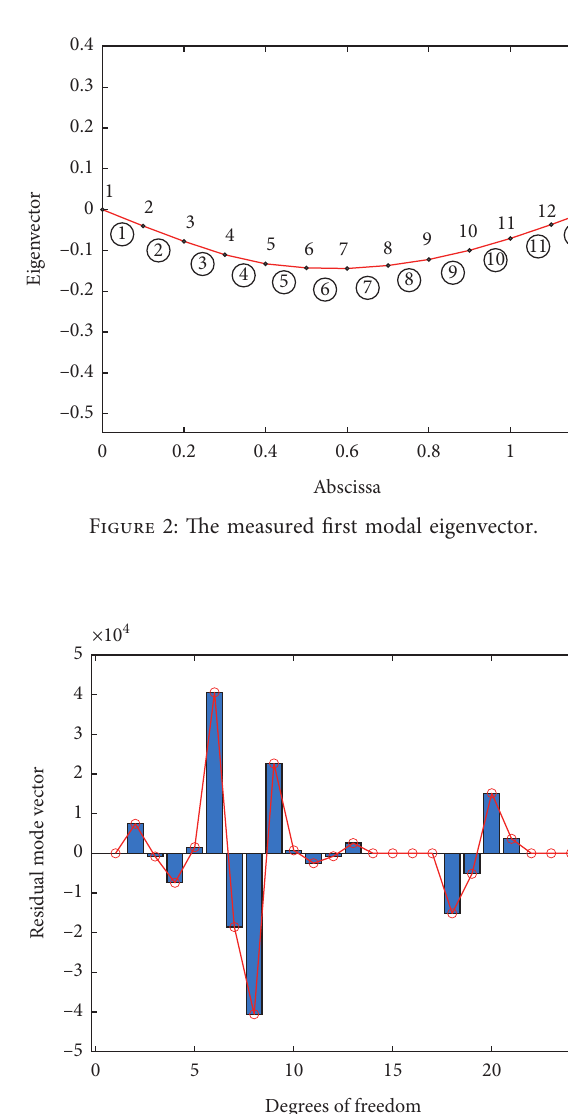
Figure 3: The distribution diagram of residual mode